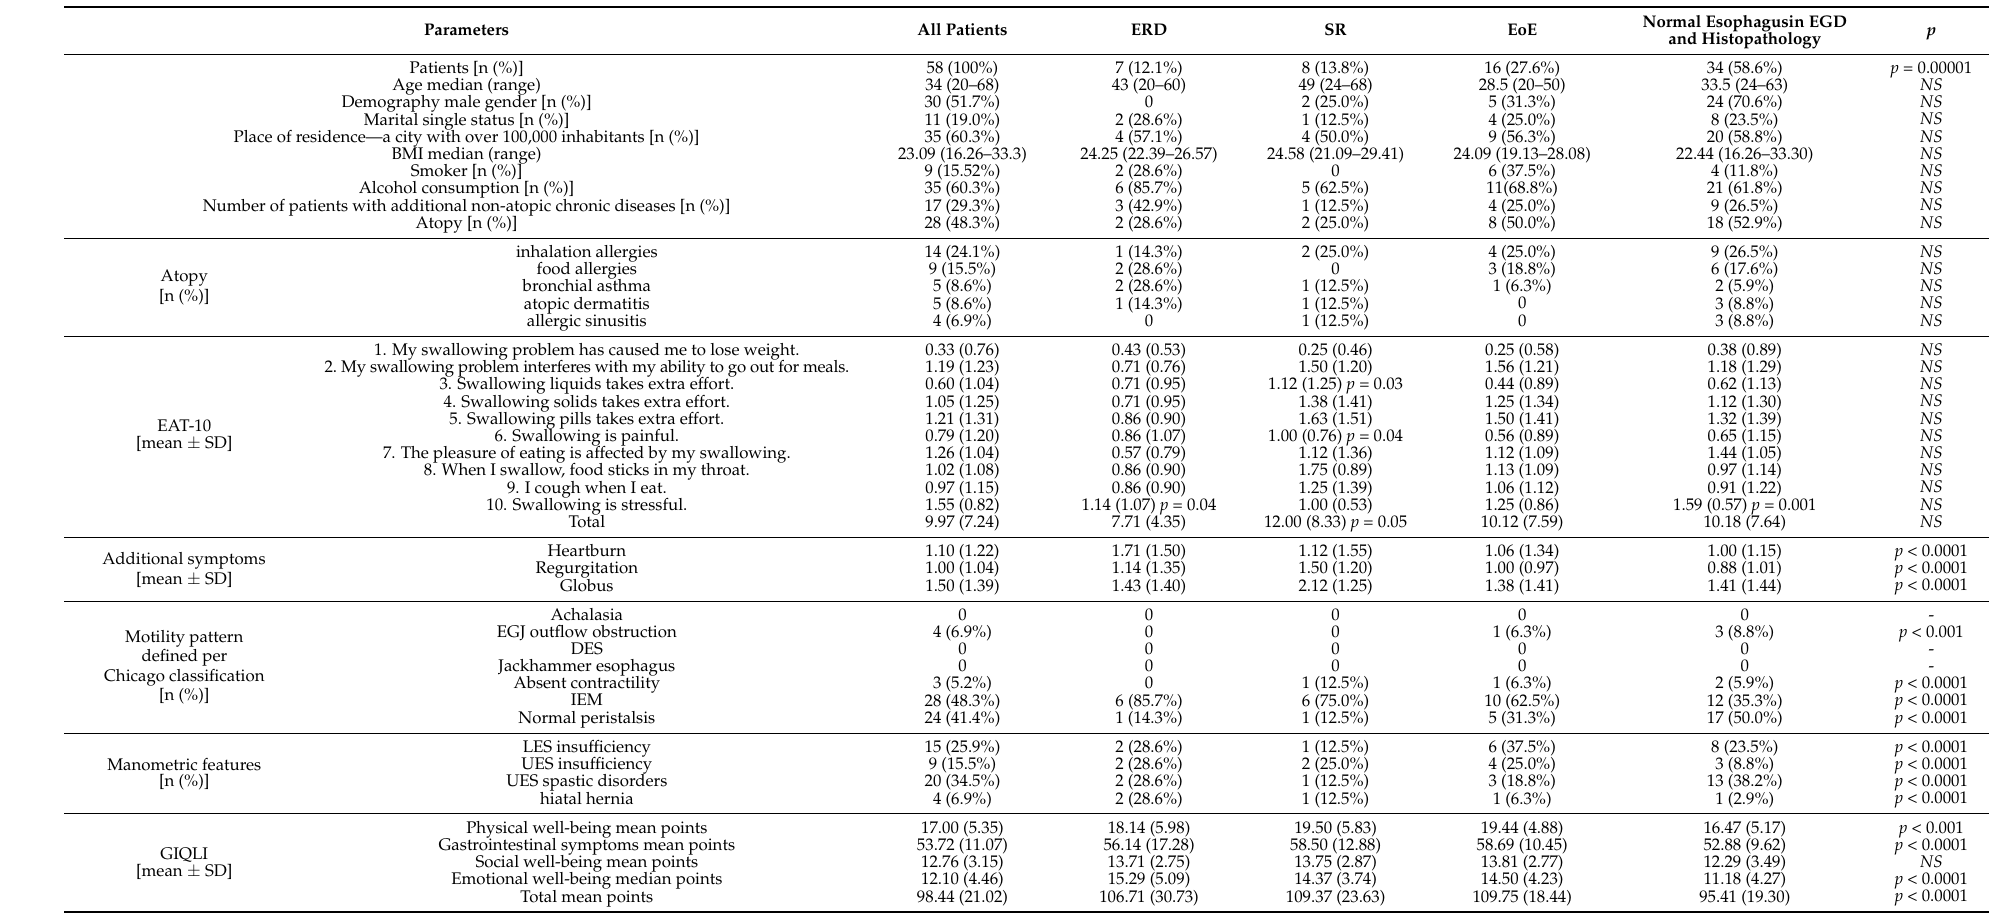
Table 1. Demographic and clinical characteristics of